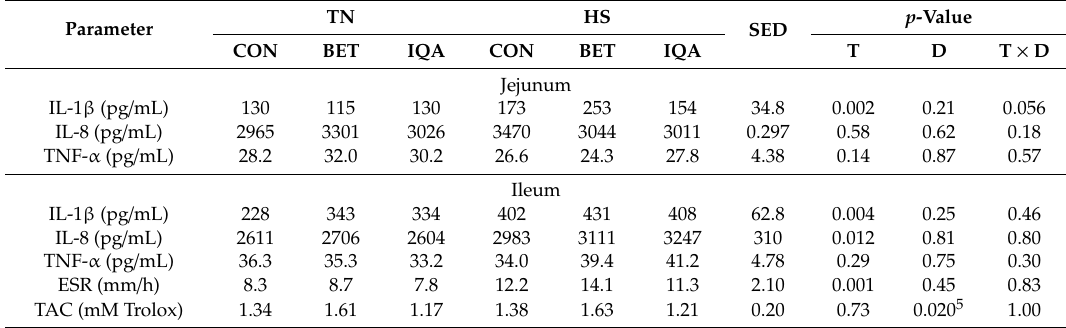
Table 5. Effect of thermoneutral (TN) and heat stress (HS) conditions and control (CON), betaine (BET) or isoquinoline alkaloids (IQA) on intestinal inflammatory responses 1 .